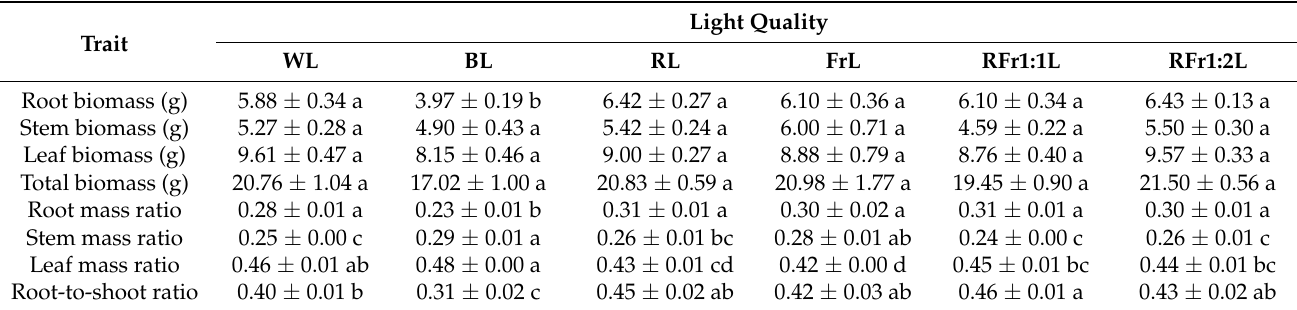
Table 2. Biomass accumulation and allocation in Cunninghamia lanceolata under different light quality treatments.